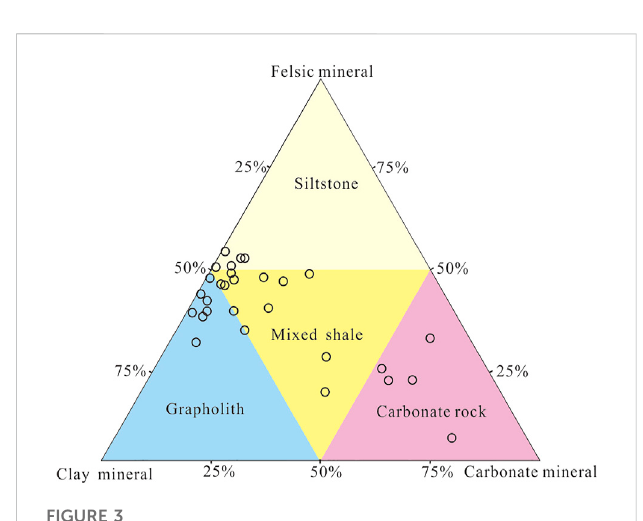
FIGURE 3 Triangular mineral composition diagram of Well